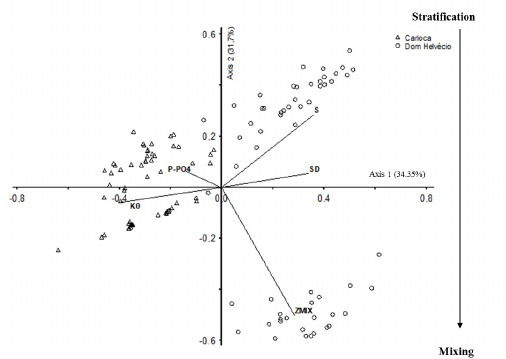
Figure 3. PCA biplots of water physical and chemical variables from lakes Carioca and Dom Helvécio (southeast Brazil), over the study period